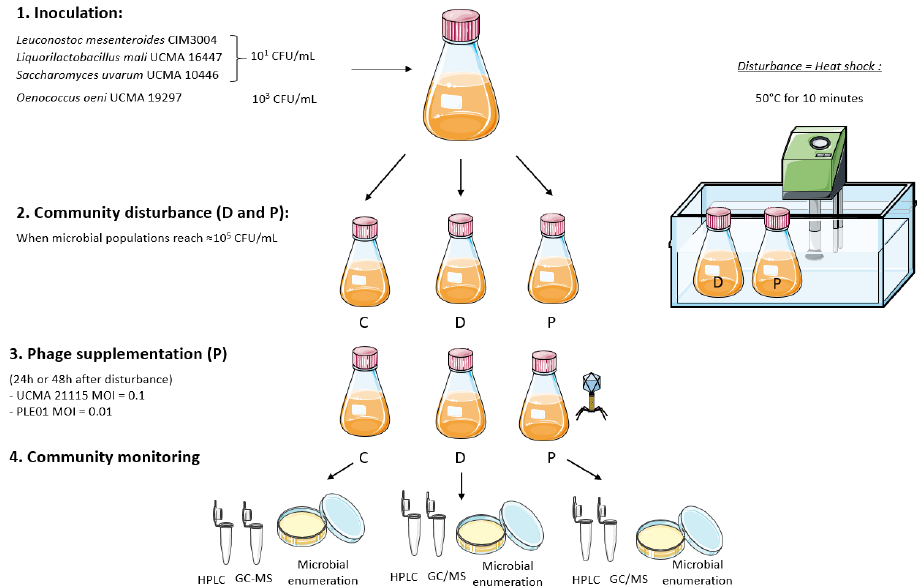
Figure 1. Experimental design of the study. The model microbial community was incubated at 25 °C or at 15 °C, and the control community (C), the community subjected to disturbance (D) and the community subjected to disturbance followed by phage addition (P) were monitored over time.